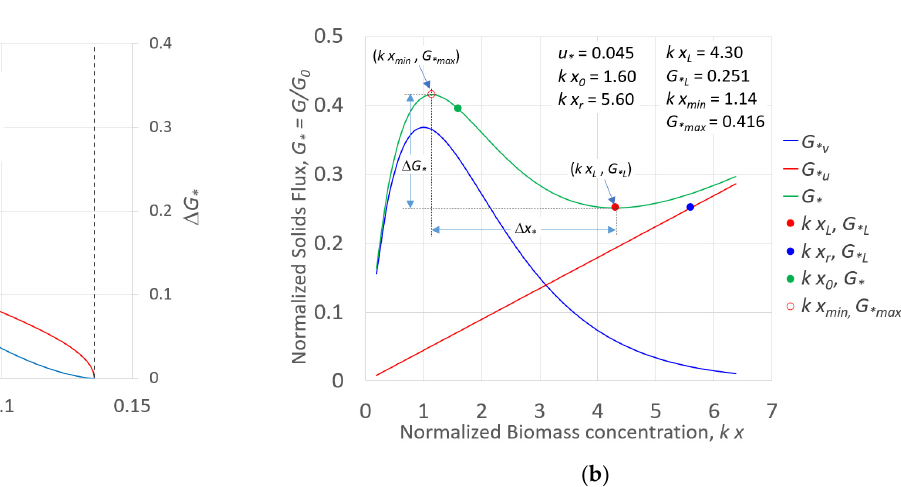
Figure 7. ( a ) Biomass concentration and solid flux domains, Δ x * and Δ G * (secondary axis), versus u * . Dots refer to the application of ( b ). ( b ) For the parameters of the example application (Tables 2 and 3), G *v , G *u , and their sum G * versus the normalized biomass concentration k x . The normalized minimum value of the biomass concentration k x min , associated with G *max , and the biomass concentration and solid flux domains are also indicated.